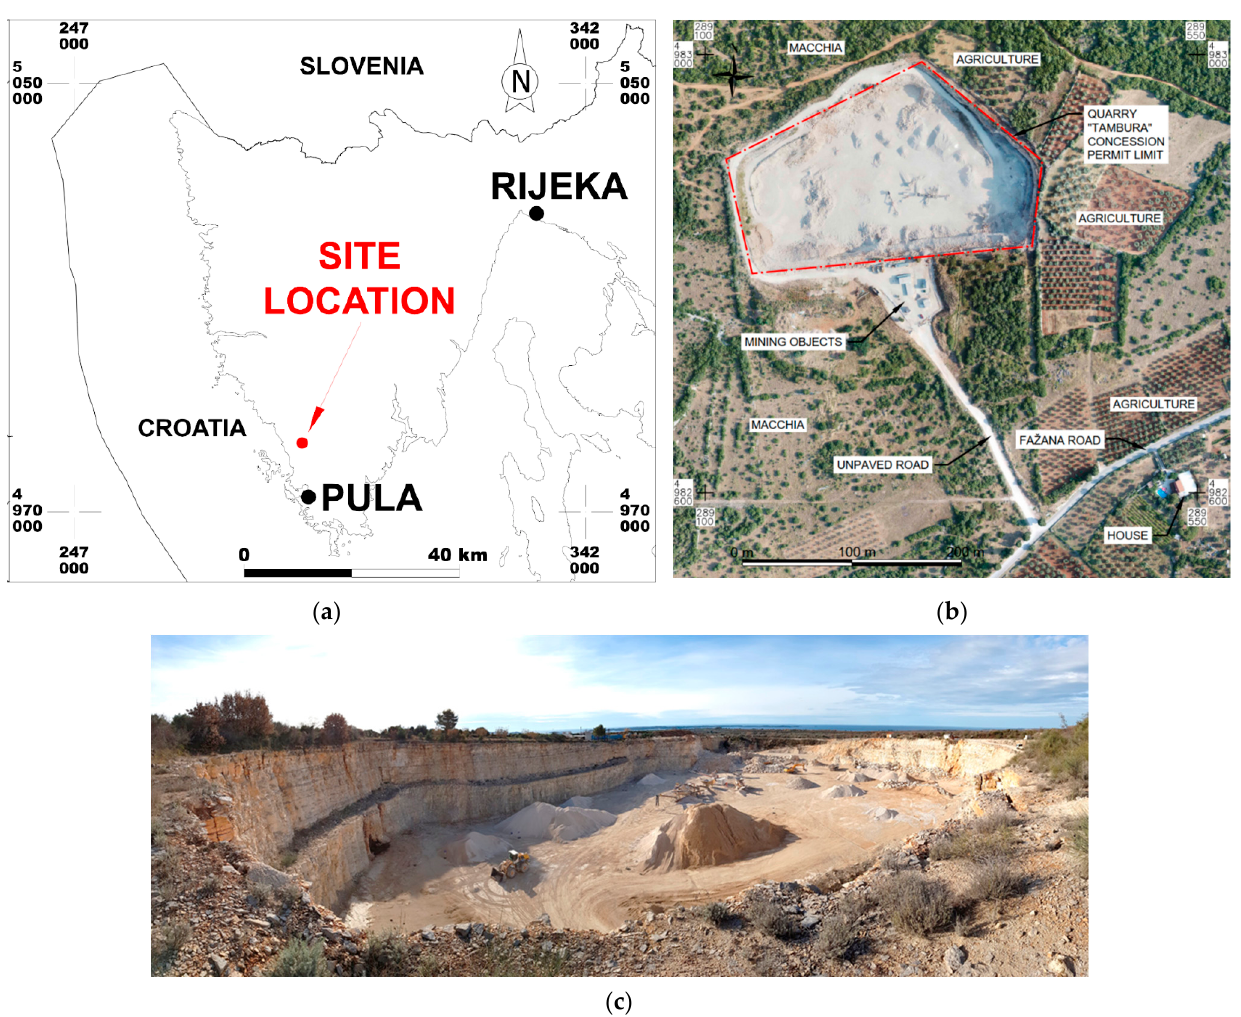
Figure 3. Site location of quarry “Tambura”: ( a ) site location, ( b ) top view of quarry “Tambura”, ( c ) and quarry working face.